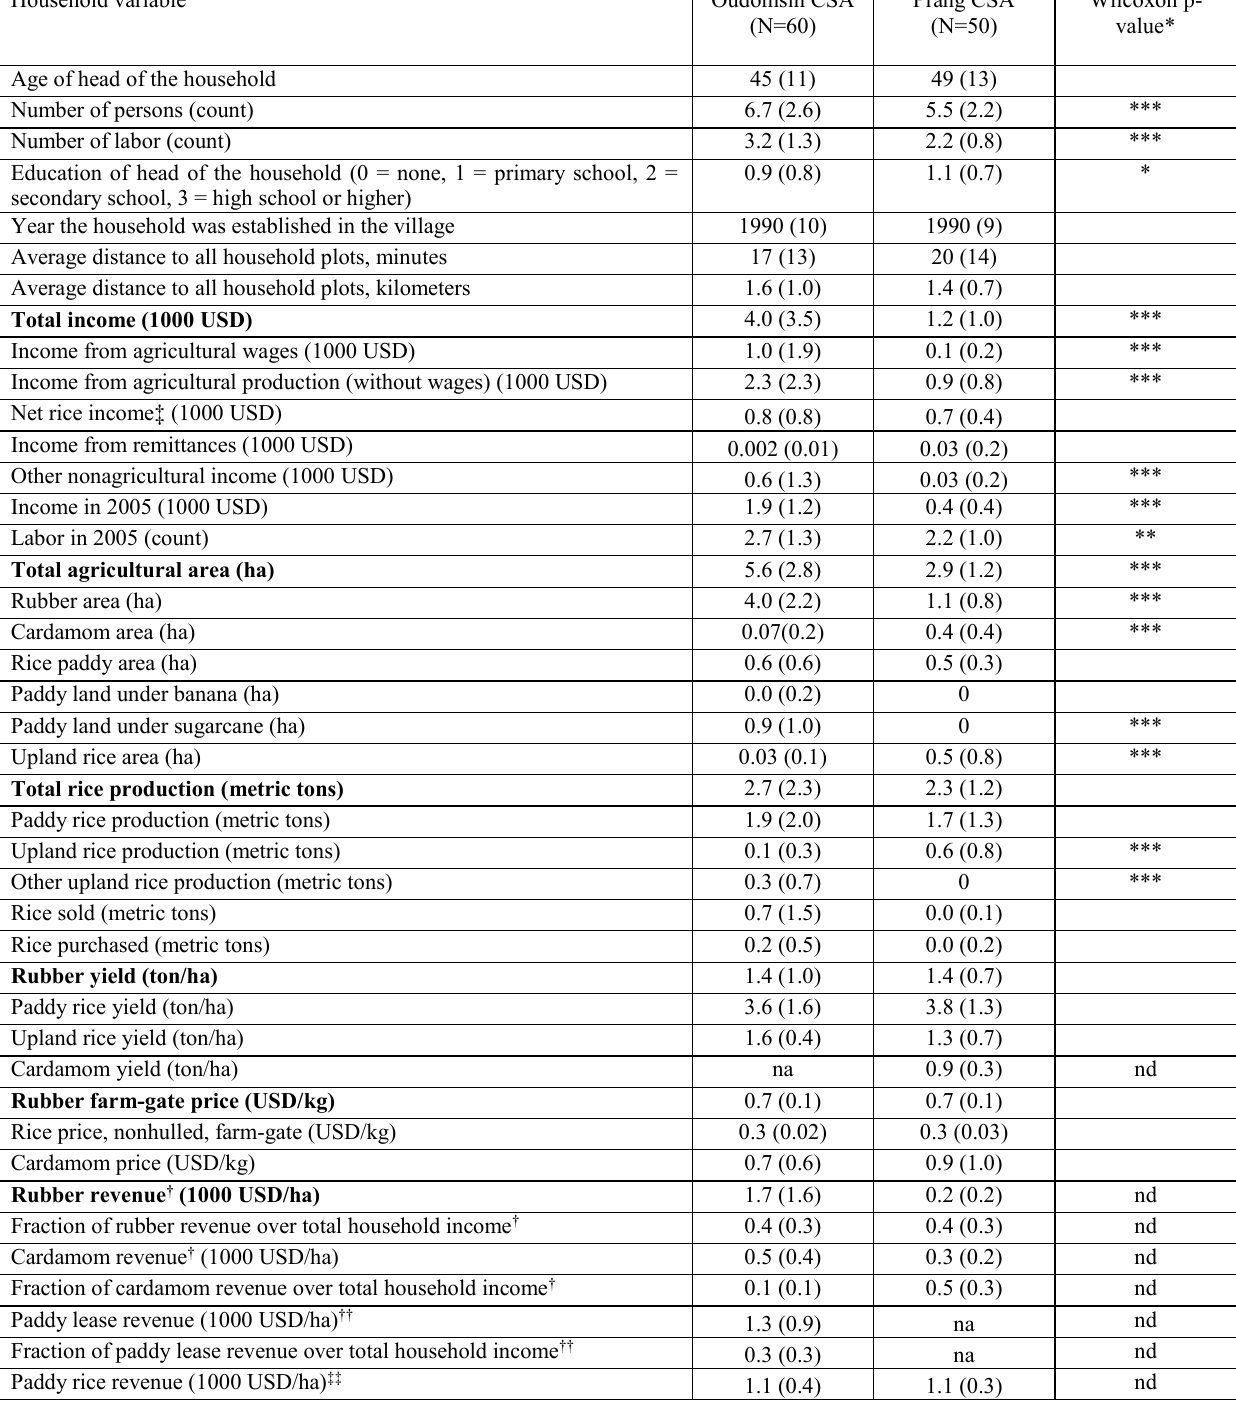
Table A1.1: Summary of household-level statistics (mean and standard deviation) for each case study area (CSA). The values reflect conditions in December 2017 unless otherwise